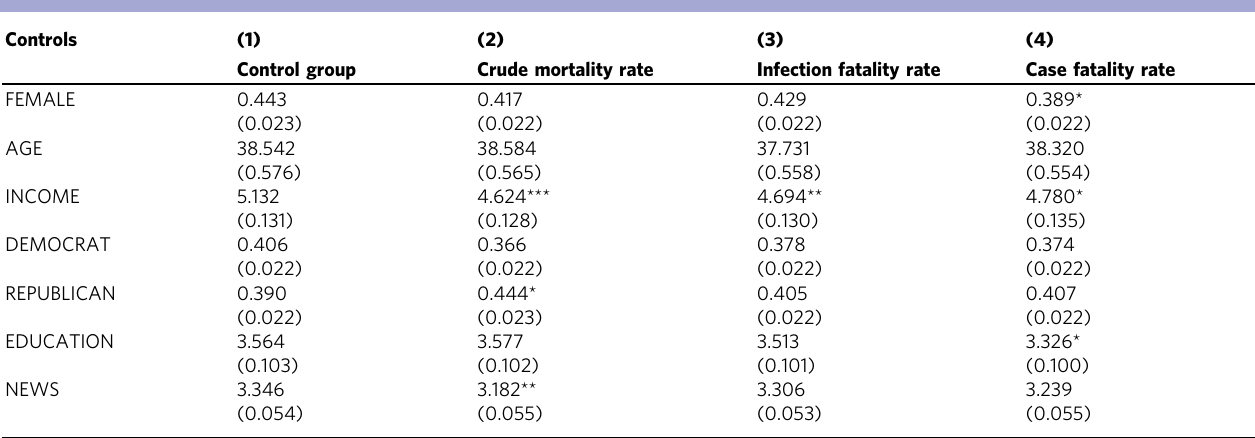
Table 2 Descriptive statistics by treatment